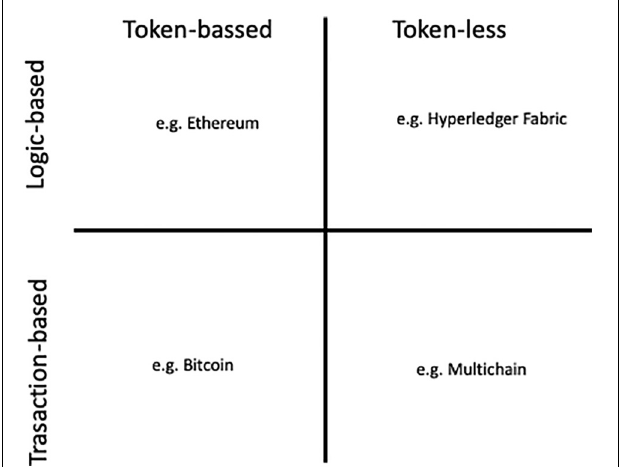
FIGURE 1 | DLT types with